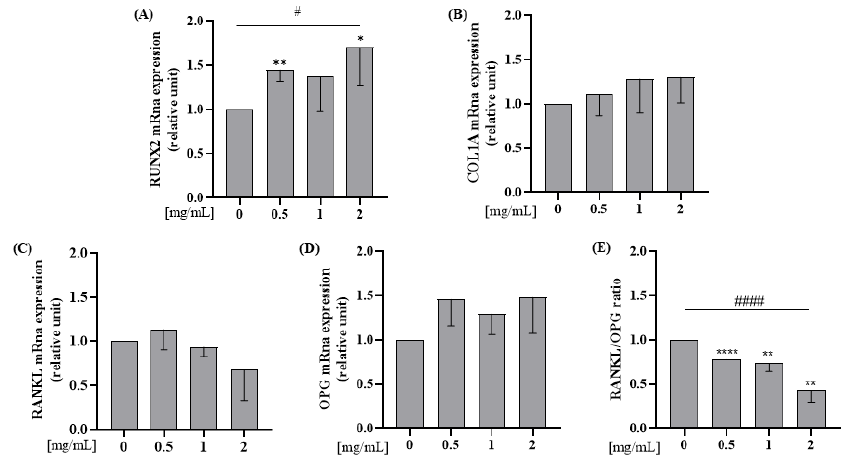
Figure 3. WP increases mRNA expression levels of RUNX2 and decreases RANKL/OPG ratio mRna